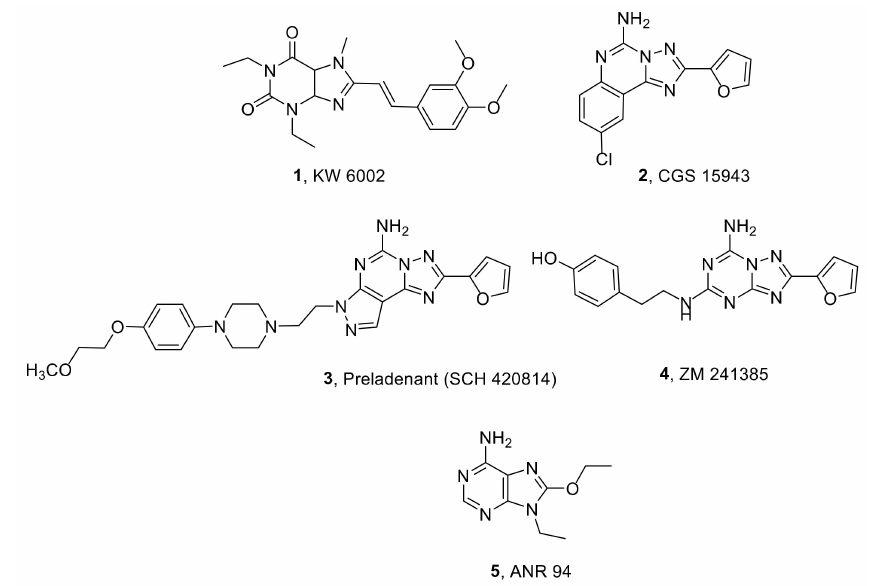
Figure 1. Structures of A 2A AR